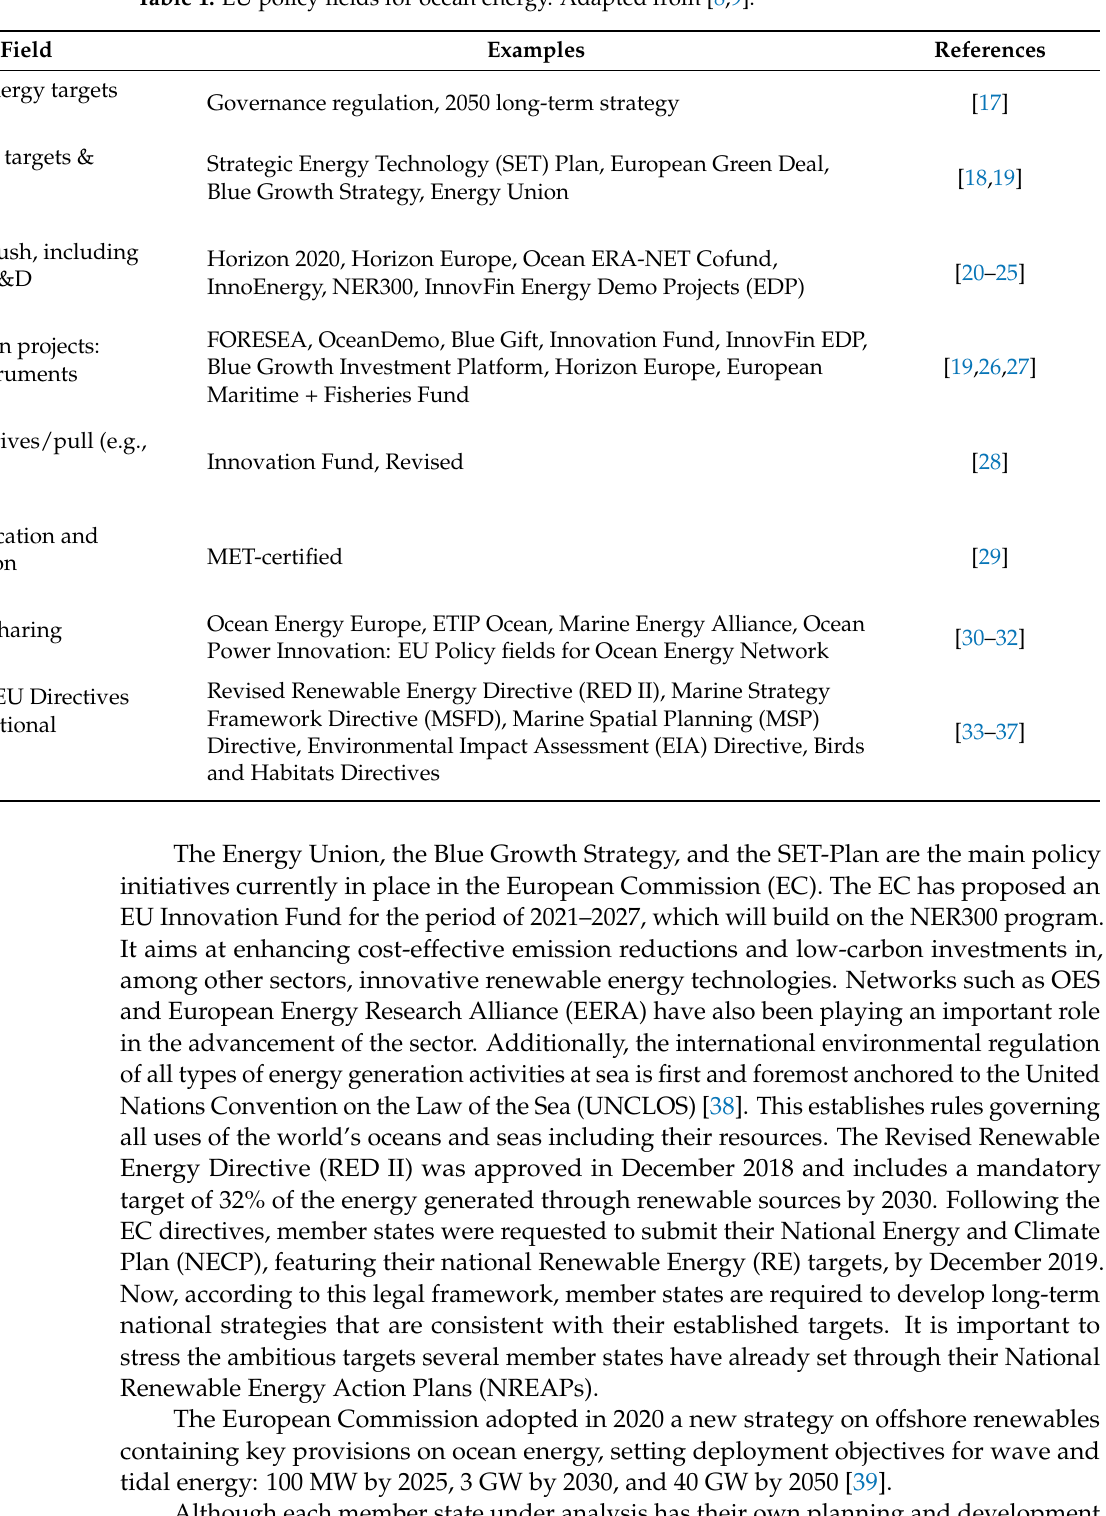
Table 1. EU policy fields for ocean energy. Adapted from